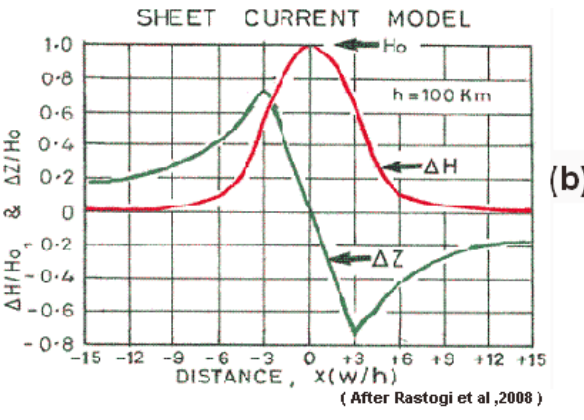
Fig. 2b. The latitude variation of H and Z components of the surface field of a horizontal band of eastward current of semi-width “ w ” at a height of h above the plane Earth (after Rastogi et al., 2008).